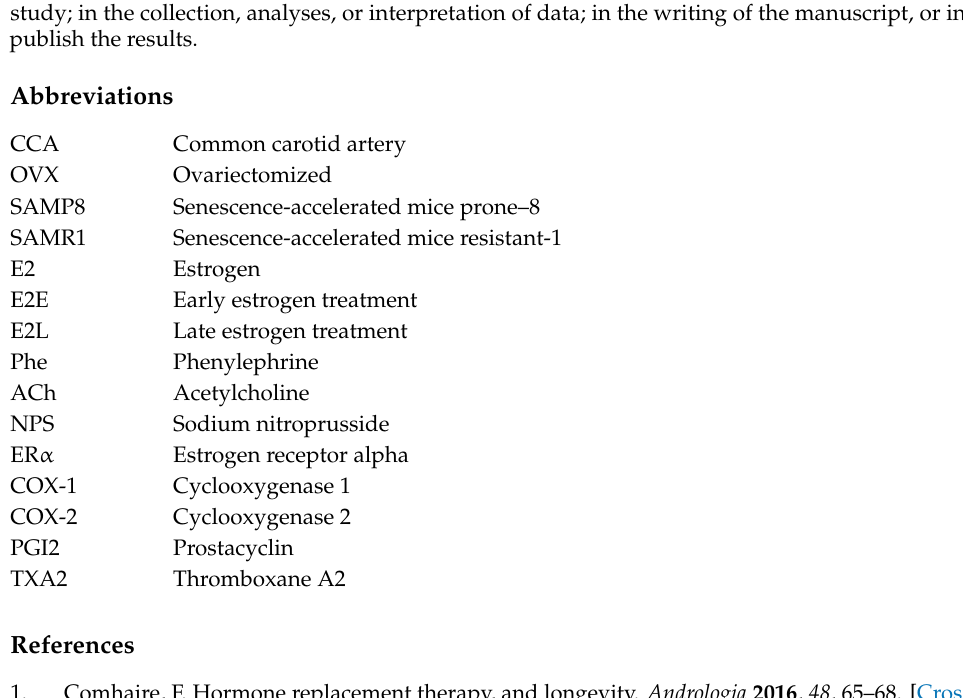
Figure S1: U46619-induced contraction; Figure S2: Acetylcholine (ACh) and Sodium Nitroprusside (SNP)-induced relaxation; Figure S3: E ff ects of reactive oxygen species (ROS) on Phenylephrine (Phe)-induced contractions; Figure S4: E ff ects of Cyclooxygenase (COX)-derived vasoactive metabolites on Phenylephrine (Phe)-induced contractions; Figure S5: Prostacyclin (PGI2) production; Figure S6: Thromboxane A2 (TXA2) production; Figure S7: Expression of the classical estrogen receptor (ER α 66) in common carotid artery; Major Resources Table S1: Animal Model; Major Resources Table S2: Vascular Reactivity; Major Resources Table S3: Primer sequences for quantitative RT-PCR; Major Resources Table S4: Primer sequences for quantitative DNA methylation; Major Resources Table S5: